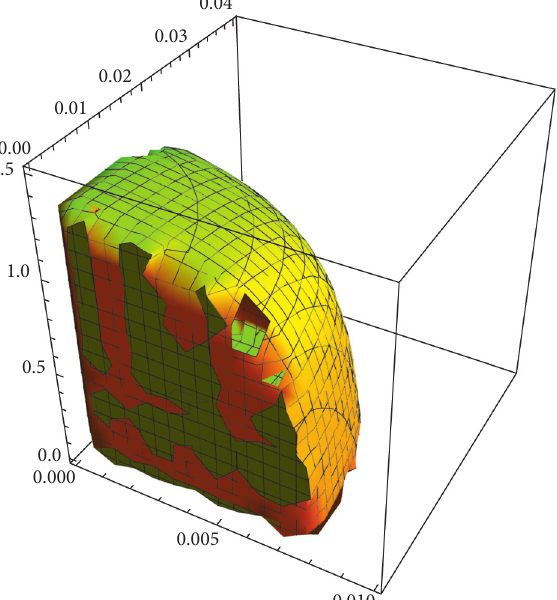
Figure 6: The stability region of the